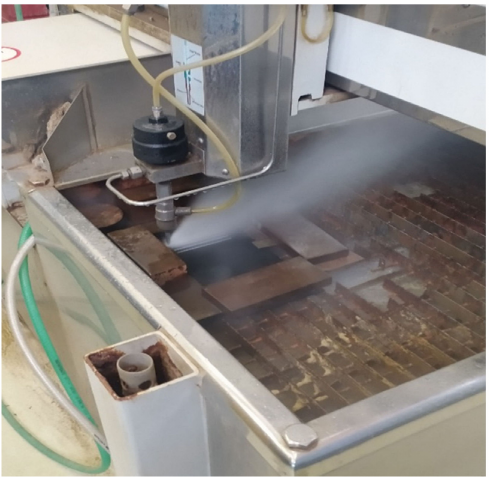
Figure 2. AWAC CNC waterjet cutting machine AWJ CT 0806: waterjet cutting process.